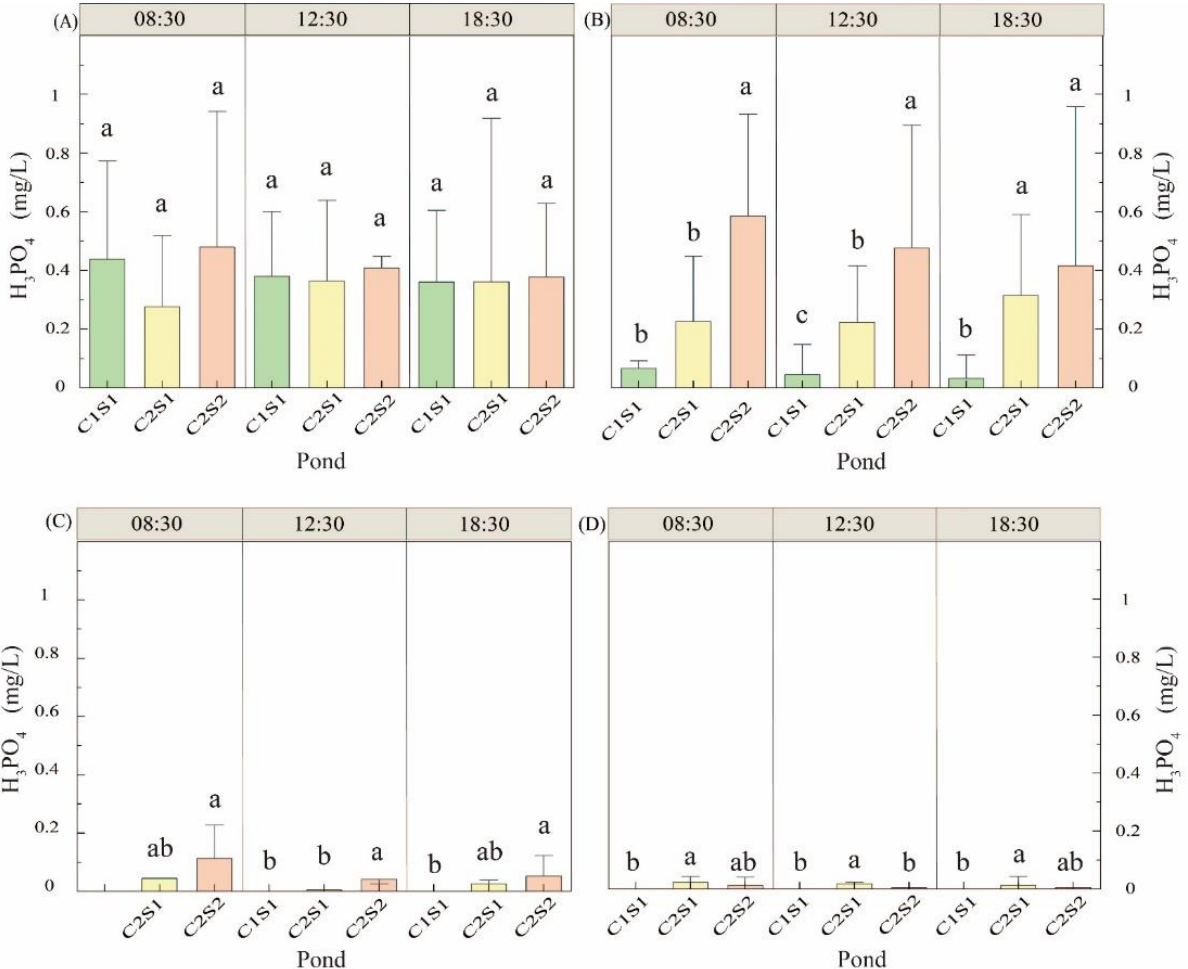
Figure 5. Monthly variation of water orthophosphate (H 3 PO 4 ) in different pond. ( A ) July; ( B ) August; ( C ) September; ( D ) October. Values with the same letter are not significantly different (LSD post hoc test).